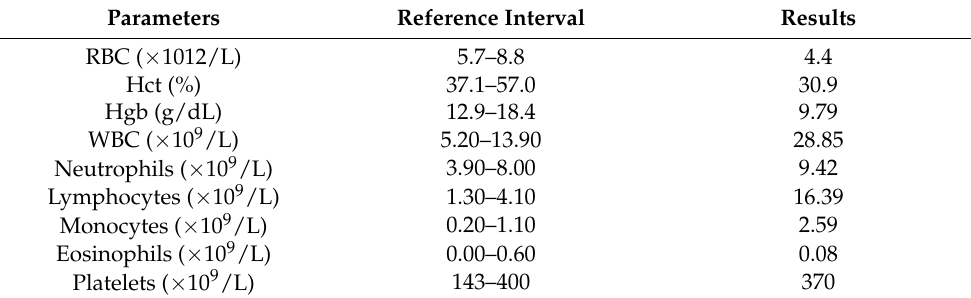
Table 1. Complete blood count results of the patient.